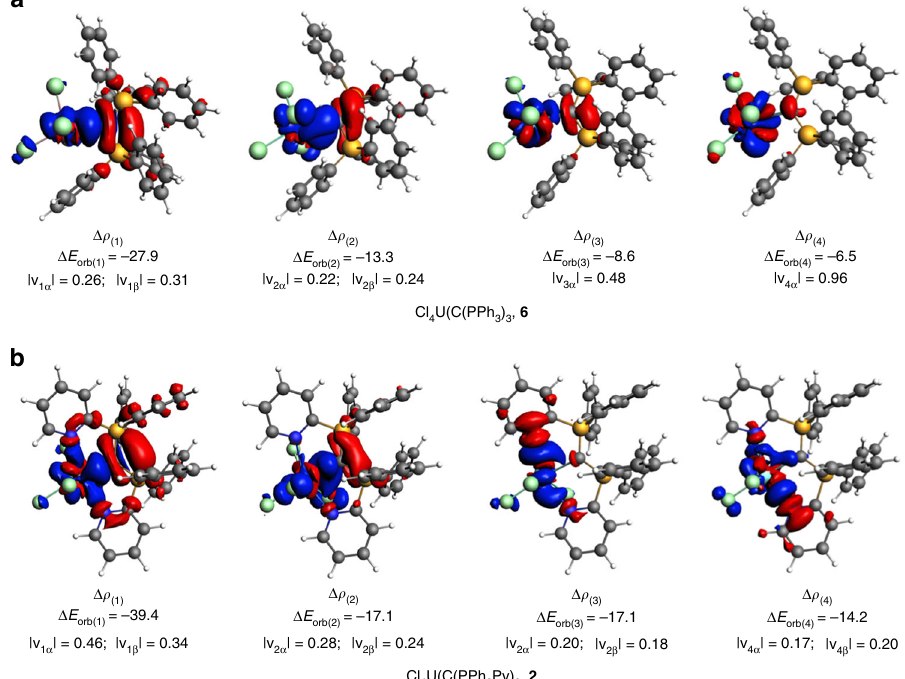
Fig. 5 Plot of the deformation densities Δ ρ together with the associated interaction energies Δ E orb . Deformation densities Δ ρ 1 − 4 of the pairwise orbital interactions in 6 ( a ) and 2 ( b ) between UCl 4 and the CDP ligand. The energies are in kcal mol − 1 . The charge eigenvalues ν give an estimate of the relative size of the charge migration. The direction of the charge fl ow is red → blue Table 2 Calculated NBO compositions of the U − C natural orbitals in the complexes 2, 4, and 6 σ -bond π